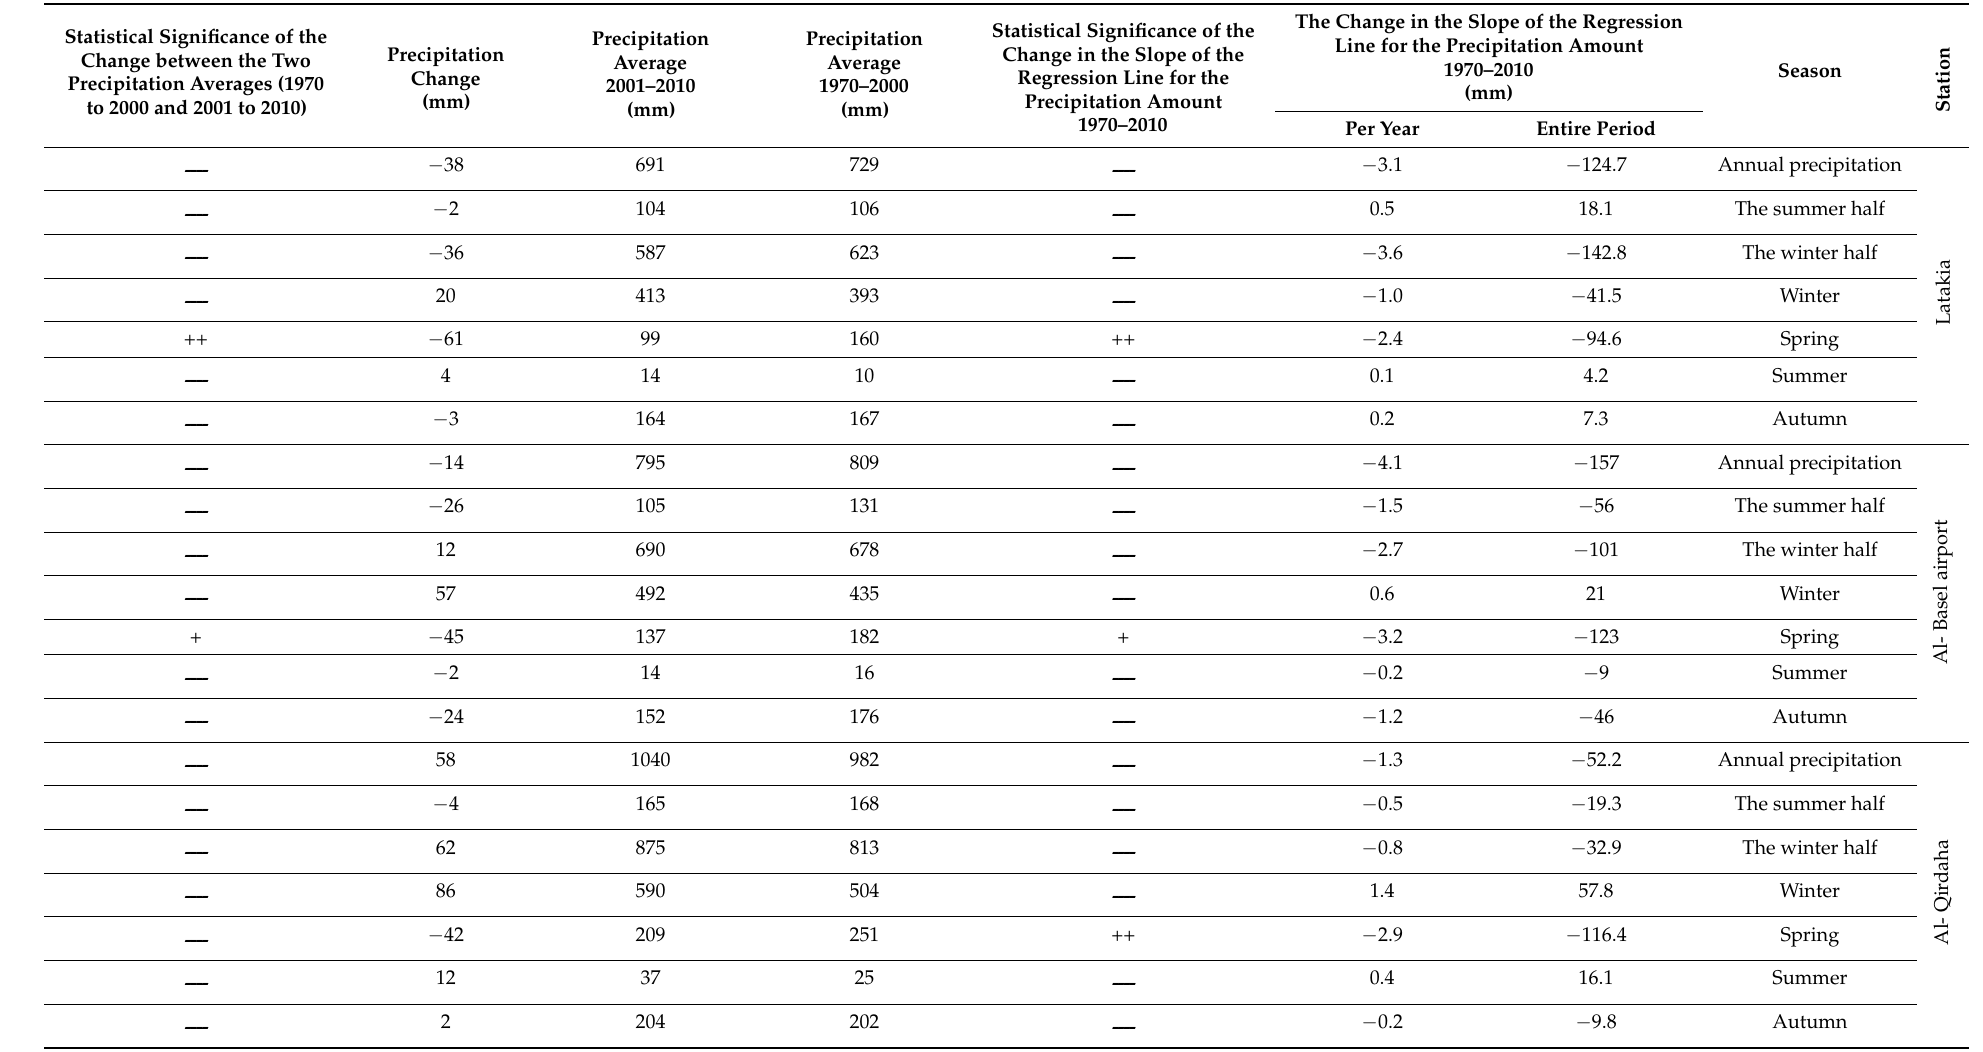
Table 2. The slope of the regression line for precipitation and the statistical significance of the slope of the precipitation regression line with the averages. Statistical Significance of the Change between the Two Precipitation Averages (1970 to 2000 and 2001 to